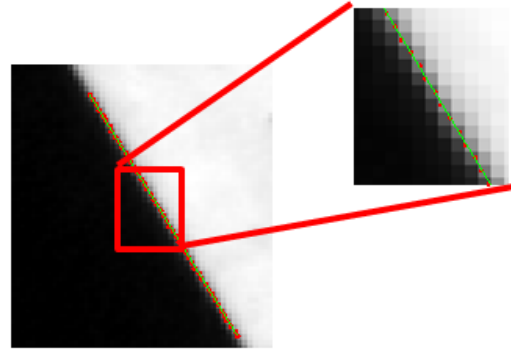
Figure 2. Sub-pixel edge location and least square line fitting